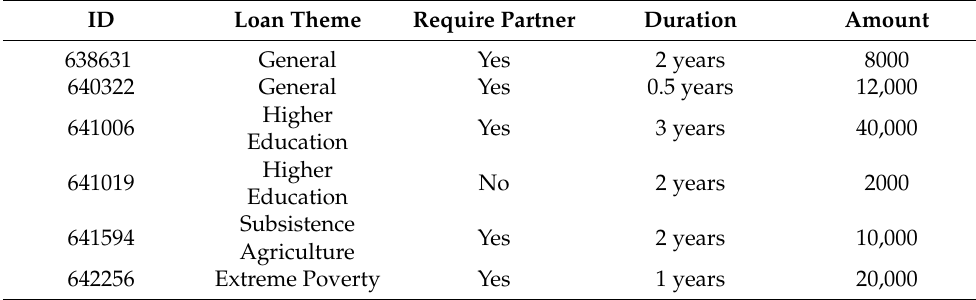
Table 4. Examples of the loan